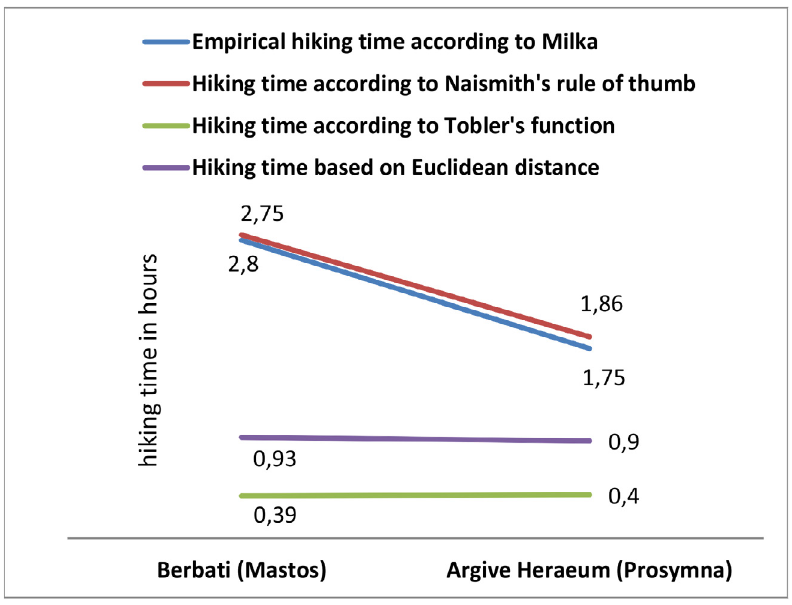
Figure 2. Correlation of various mobility algorithms with empirical data reported by E. Milka (personal communication, April 2,